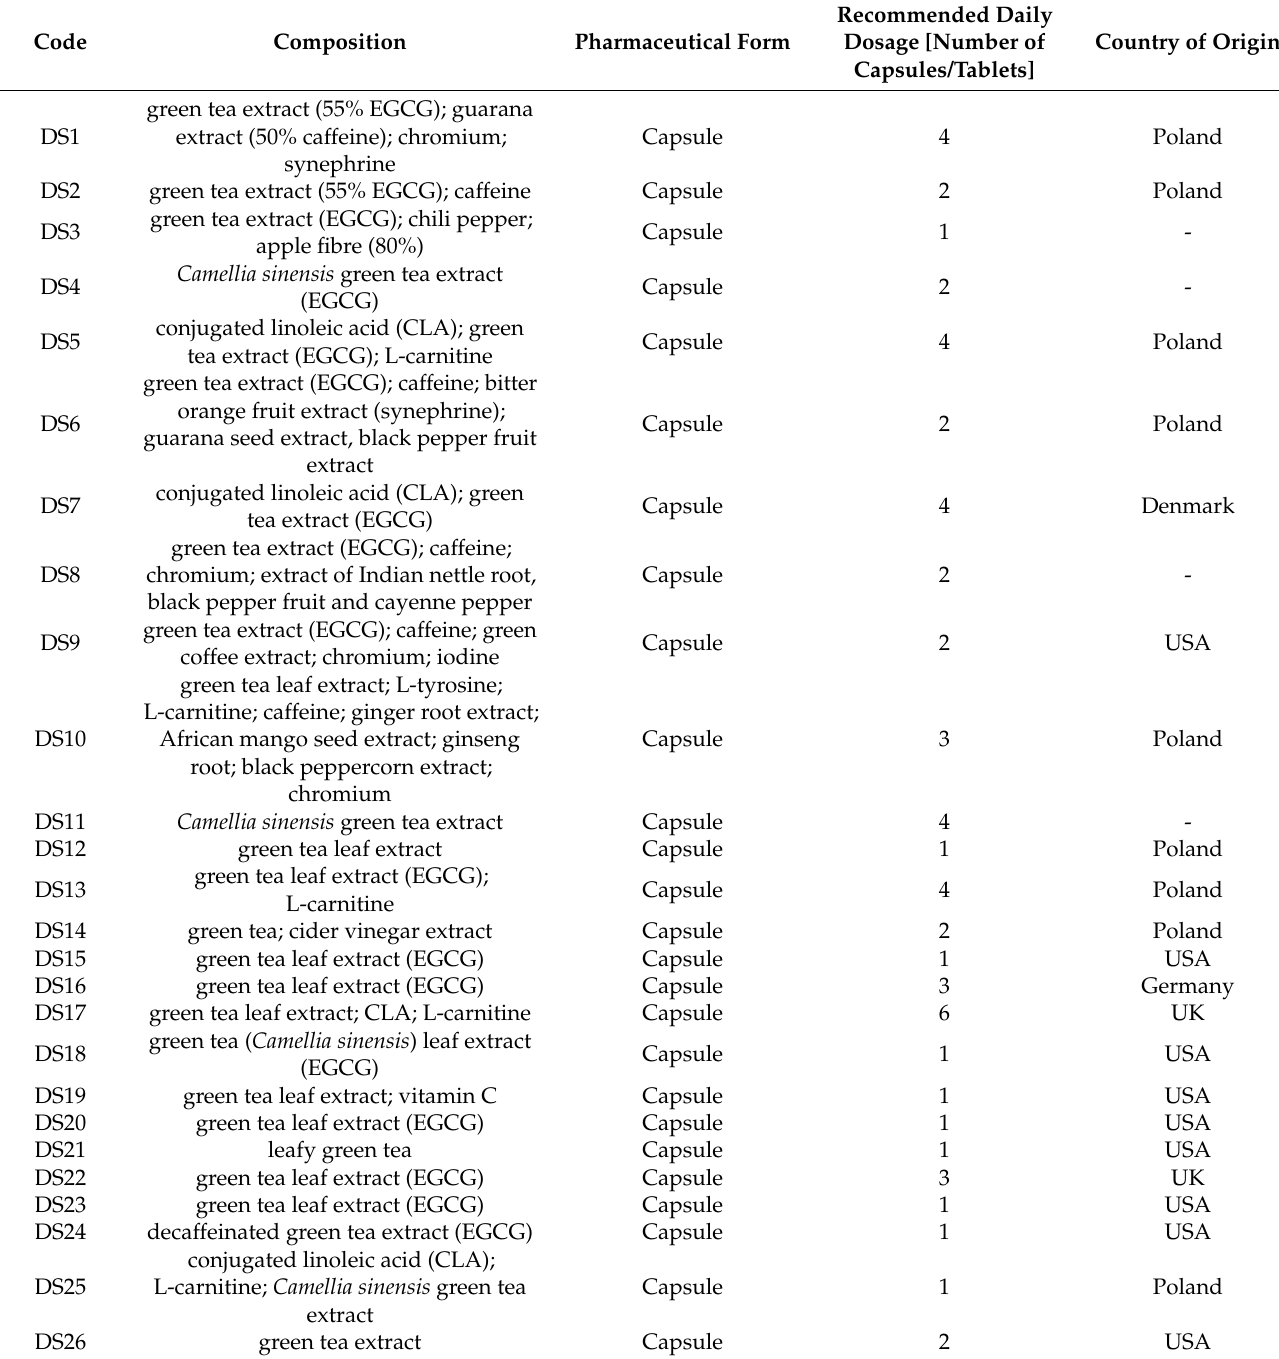
Table A1. Characteristics of the dietary supplements analysed based on information contained on the